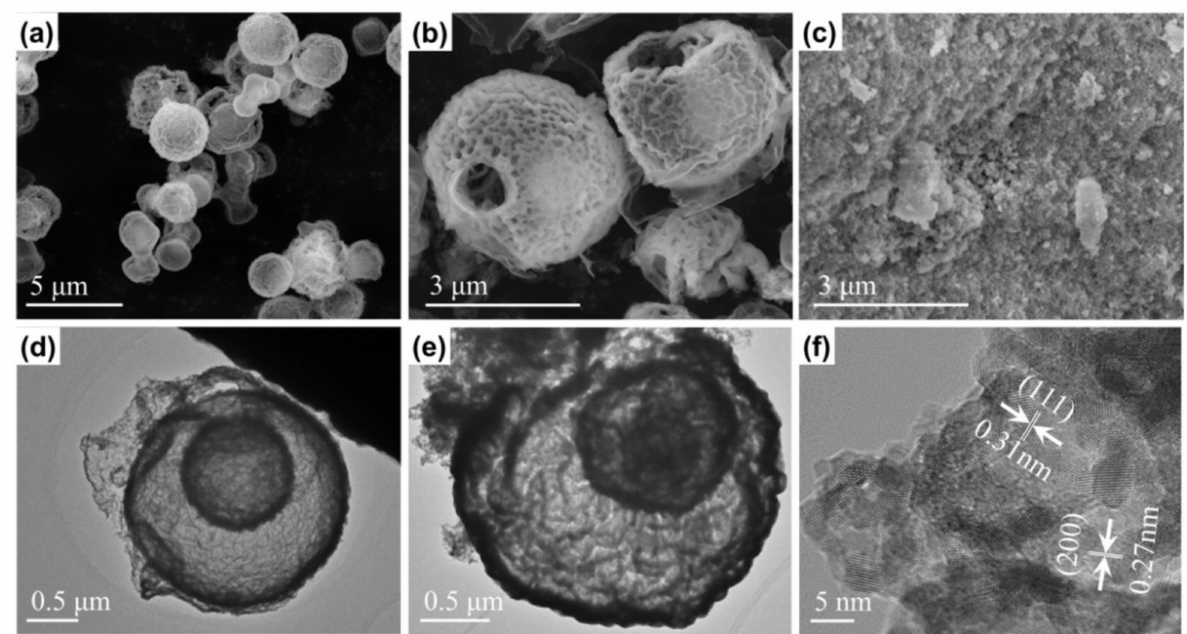
Figure 4. SEM images of Mn-CeO 2 (HT) ( a , b ) and Mn-CeO 2 (CP) ( c ), and TEM image ( d , e ) and high resolution TEM image ( f ) of Mn-CeO 2 (HT). Reproduced with permission from Reference [26]; copyright (2016),